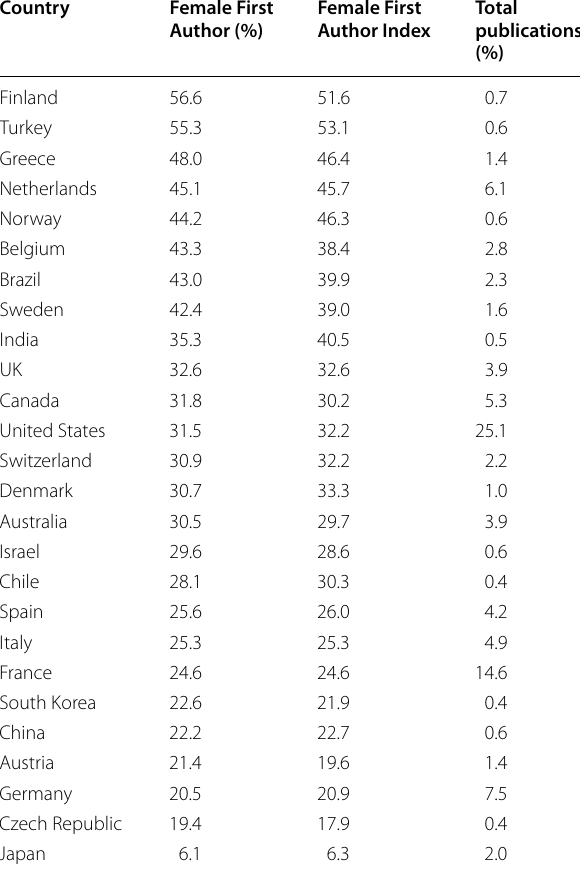
Table 1 Female First Authorship and FFA-index by